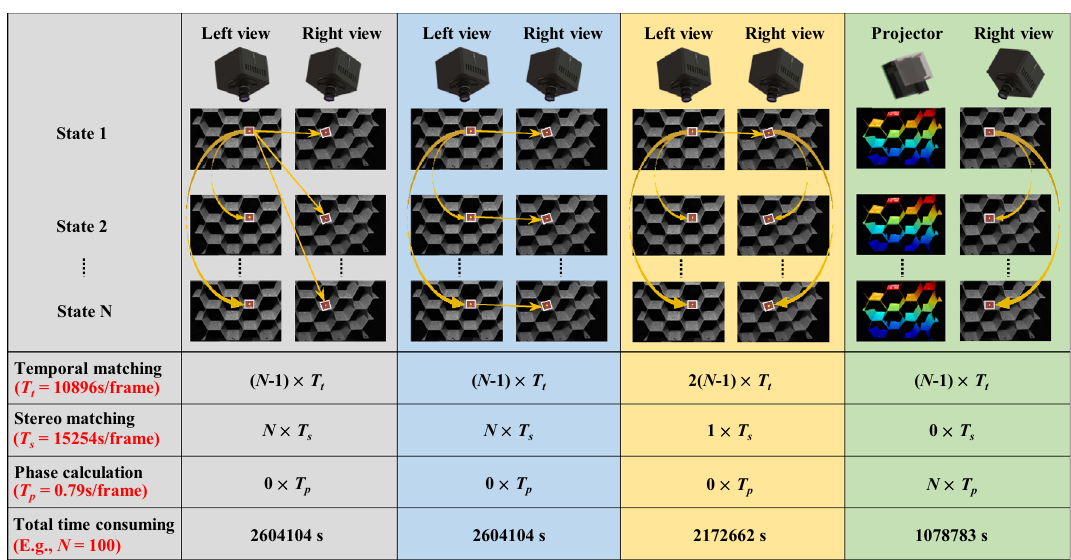
Figure 7. Comparison of computational efficiency for different strategies in stereo-DIC and proposed DIC- assisted FPP